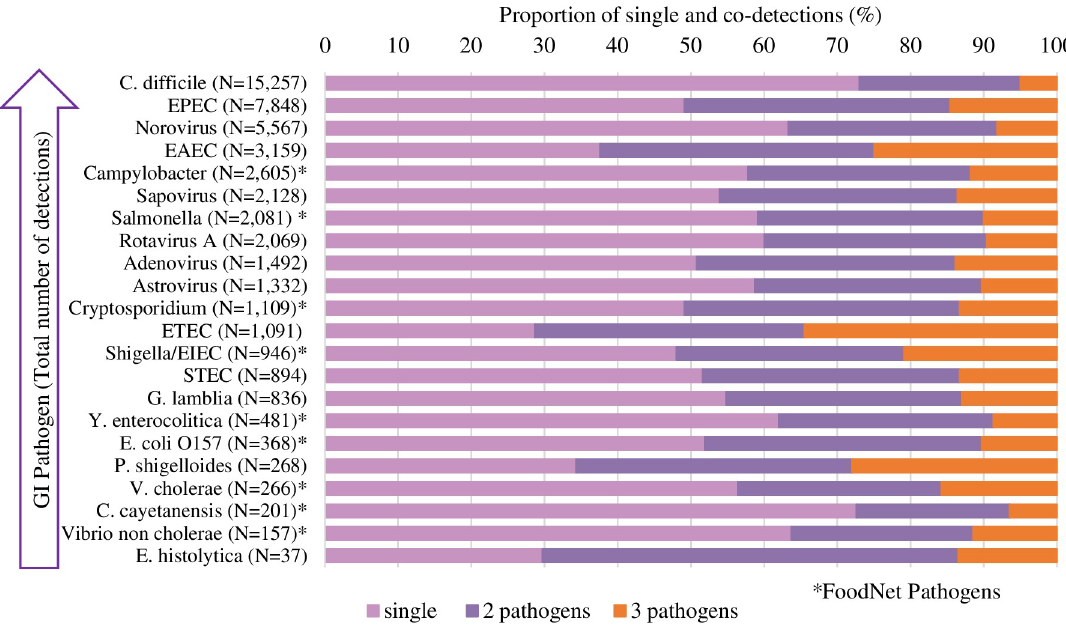
The pathogen weekly percentage of positives are shown in Fig 3. Overall, the data from Bio- Fire Trend suggests a clear seasonality for several GI pathogens. Astrovirus and norovirus had increased percentage of positives during the winter months (January–March), while the detec- tion of rotavirus increased in the Spring (April and May). Both sapovirus and adenovirus did